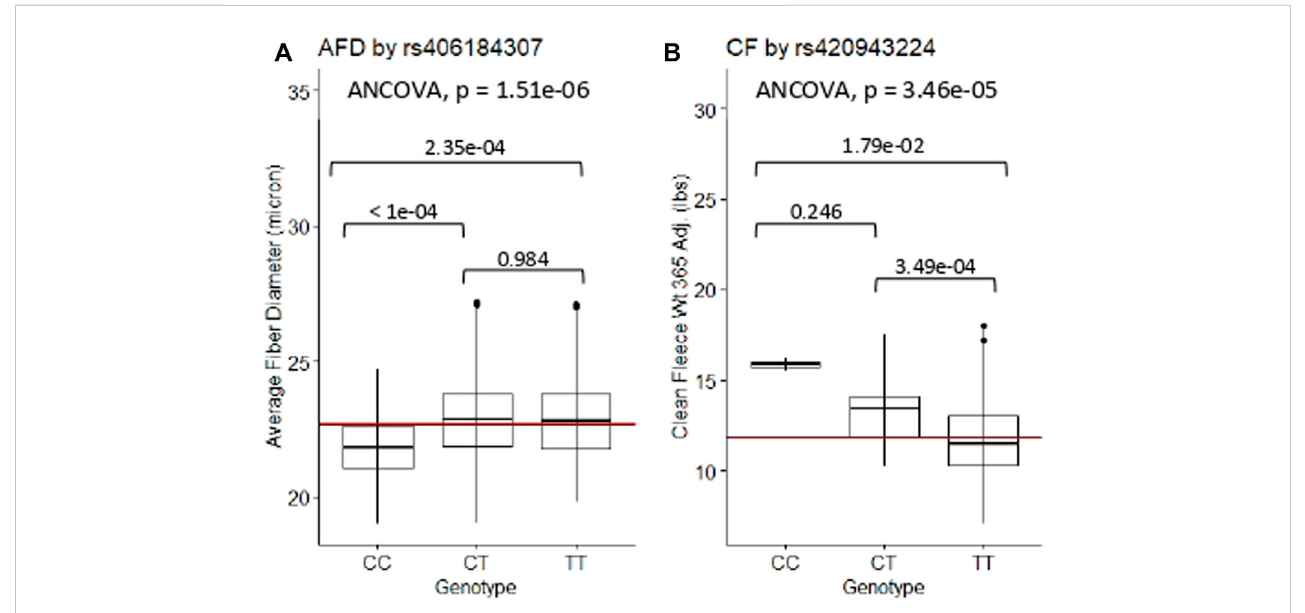
ANCOVAandpost-hocTukeyHSDtestresultsofselectedsigni fi cantSNPs. (A) Average fi berdiameteragainstSNPrs406184307,and (B) Clean fl eecewt. 365 adj. against signi fi cant SNP rs420943224. The red horizontal lines indicate the trait means. AFD, average fi ber diameter; CF, clean fl eece wt. 365